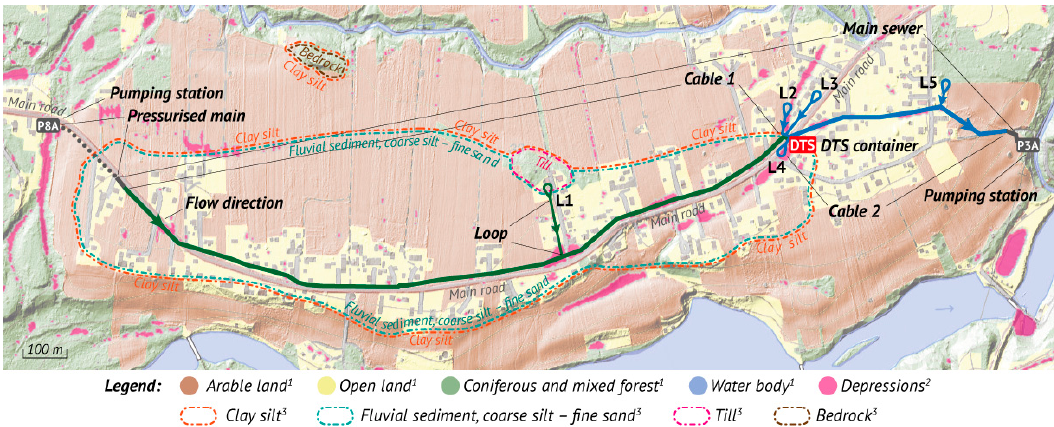
Figure 1. Map of the study area with a diagrammatic plan of the two distributed temperature sensing (DTS) cables installed in the sewer section between pumping stations P8A and P3A, connected to the DTS unit installed in the DTS container. Loops of the DTS cables are marked L1–L5. Sources for the information layers on the background map: 1 Topography maps from Lantmäteriet [23], 2 Depressions analysis by SCALGO Live [24] based on GSD-elevation data, Grid 2+ [23], 3 Soil map from Geological Survey of Sweden [25].